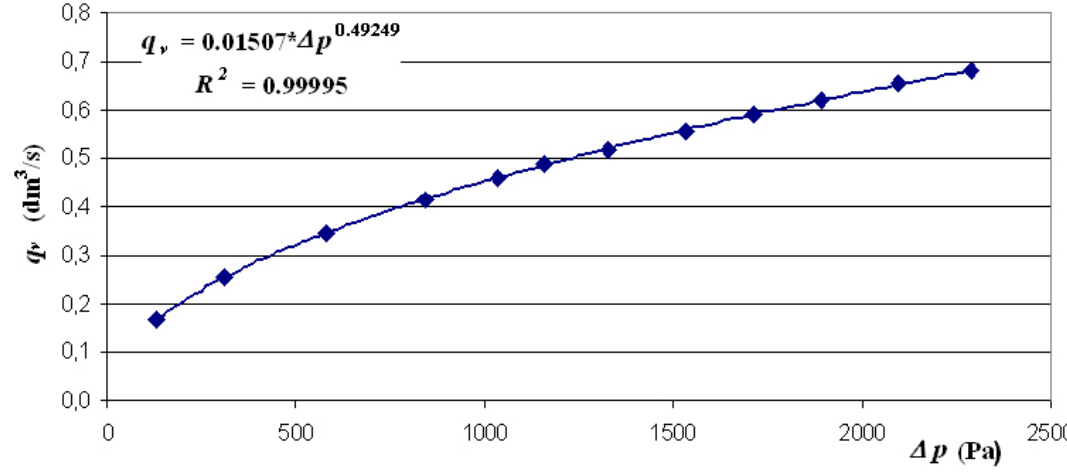
Figure 3. Flow characteristics of the tested orifice q v = f( Δ p ).